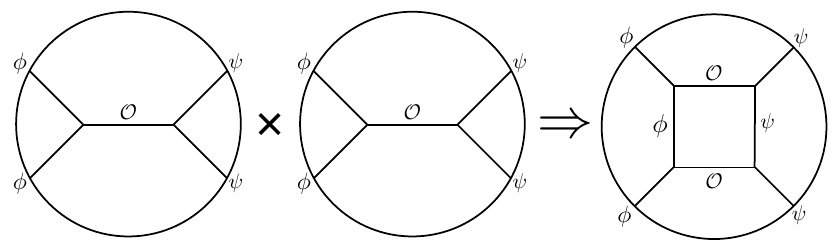
Figure 5 . We glue two, tree-level Witten diagrams along the (cid:30) and lines to create a box